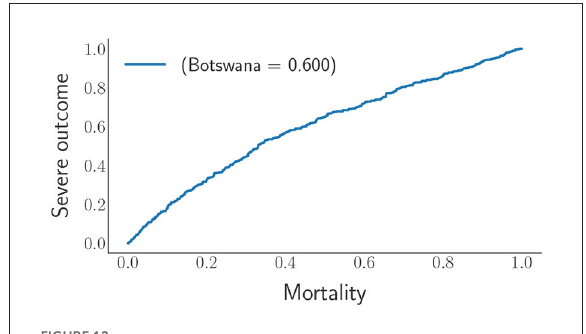
FIGURE12 The receiver operating characteristic curve of the DNN